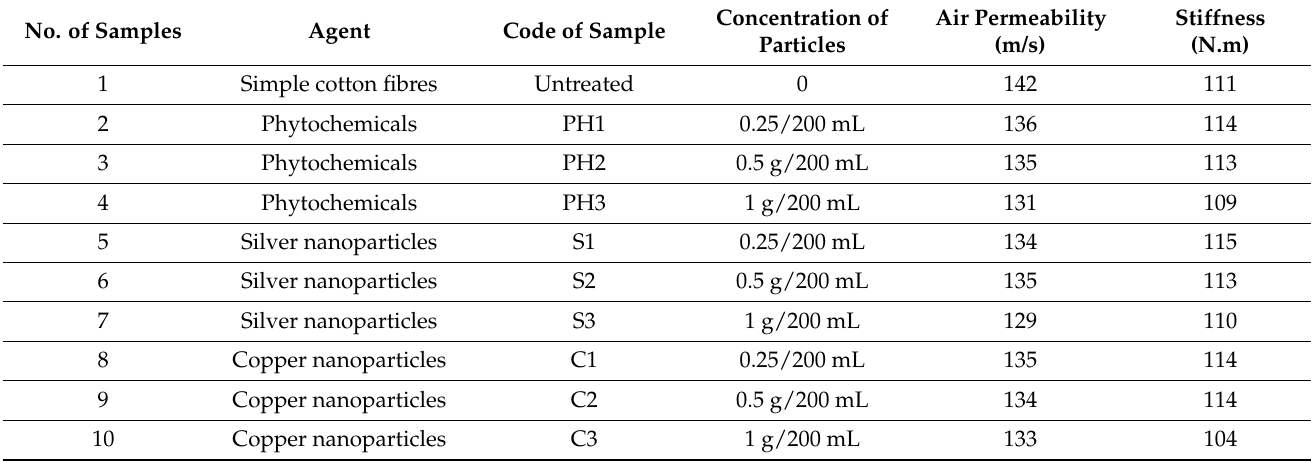
Table 7. Comfort properties of untreated and coated fabric